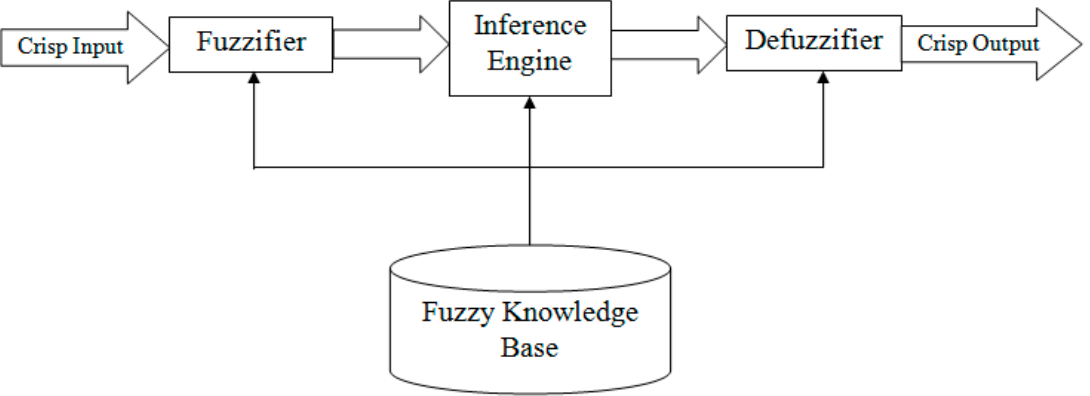
Figure 2. Architecture of the Fuzzy inference system.